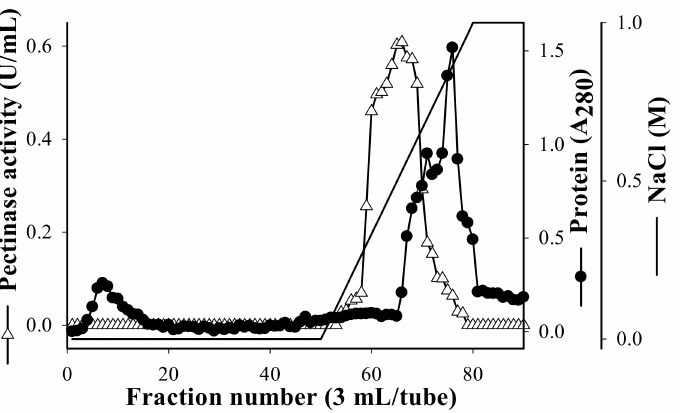
Figure 2. Elution profile of B. amyloliquefaciens TKU050 pectinase in a High Q column.